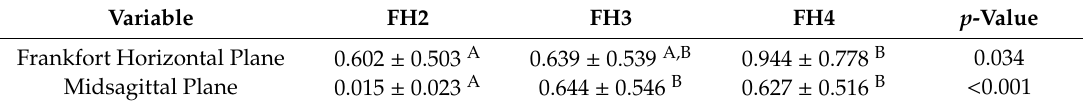
Table 3. Comparison of the spatial orientation level (SOL) between the FH planes with FH1. Variable FH2 FH3 p -Value Frankfort Horizontal Plane